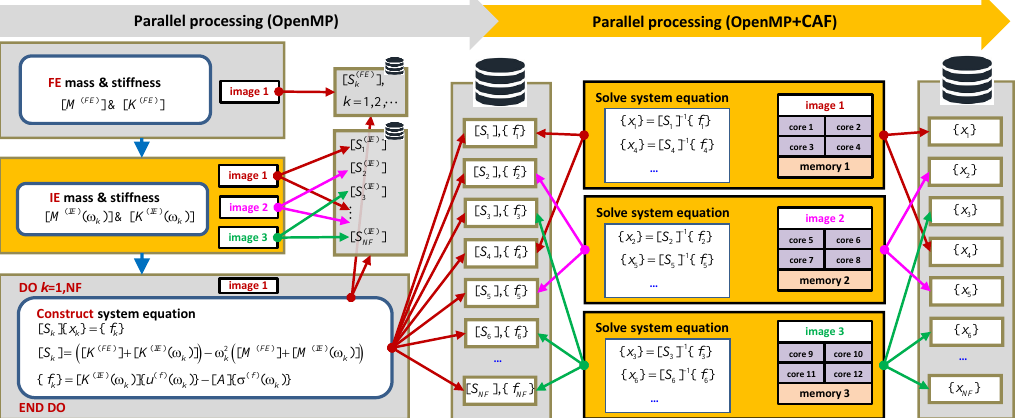
Parallel processing (OpenMP +CAF ) Parallel processing (OpenMP)